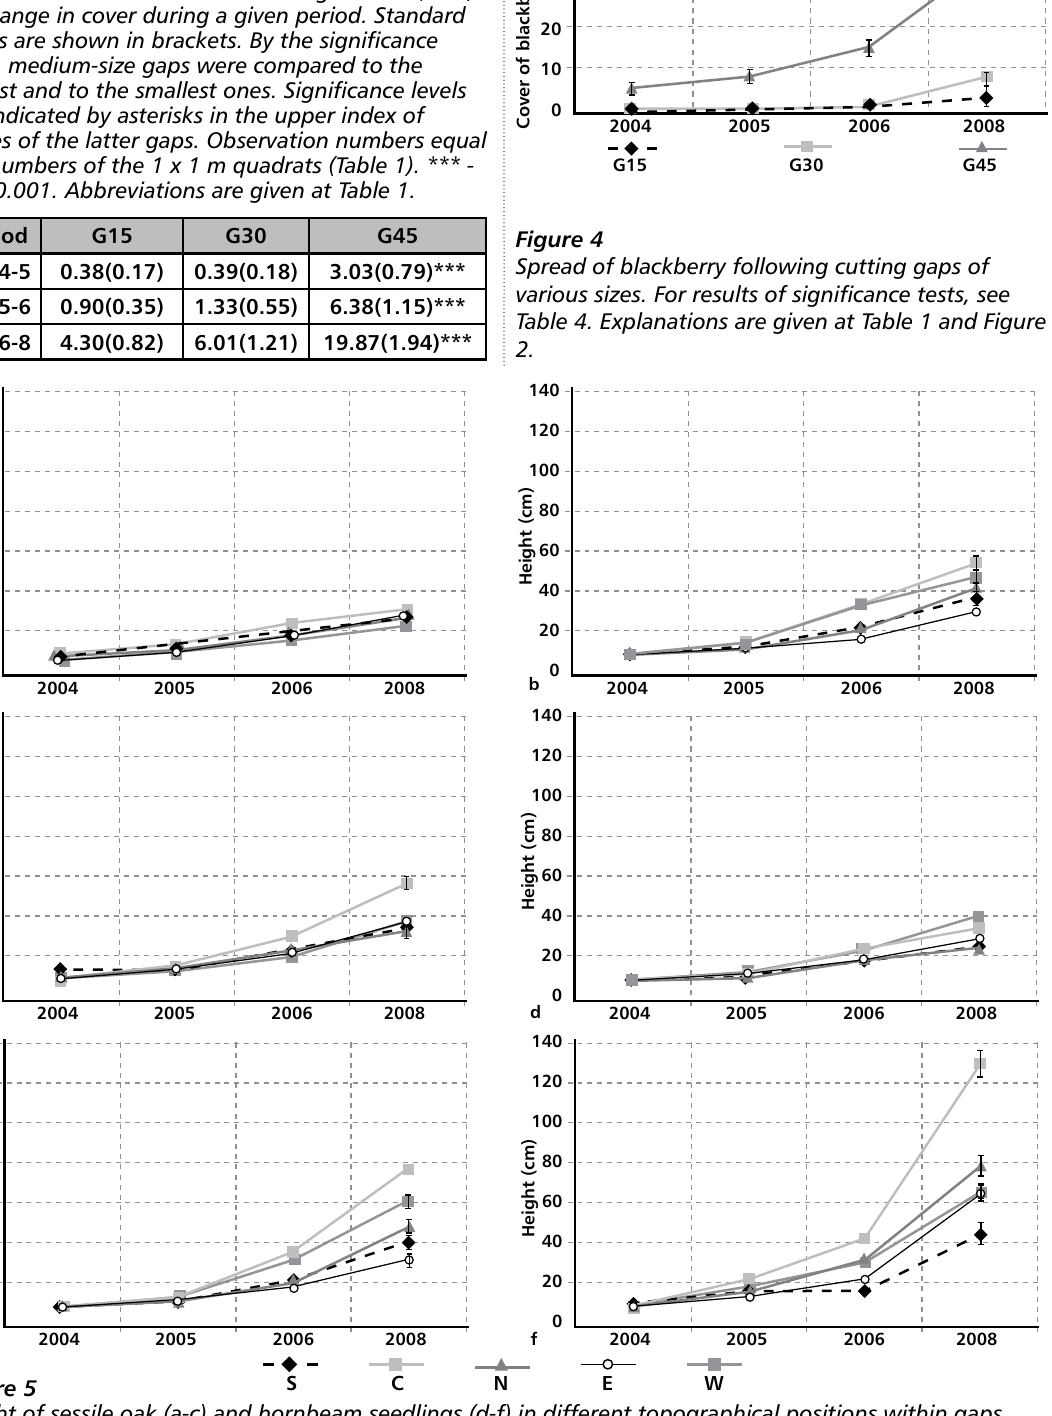
Figure 5 Height of sessile oak (a-c) and hornbeam seedlings (d-f) in different topographical positions within gaps of 15 m (a, d), 30 m (b, e) and 45 m (c, f) in diameter before (2004) and after gap cutting. Observation numbers are included in Table 2. Results of significance tests are described in Table 5. The legend is shown on Figure 5a. Other explanations are given at Table 1 and Figure 2.